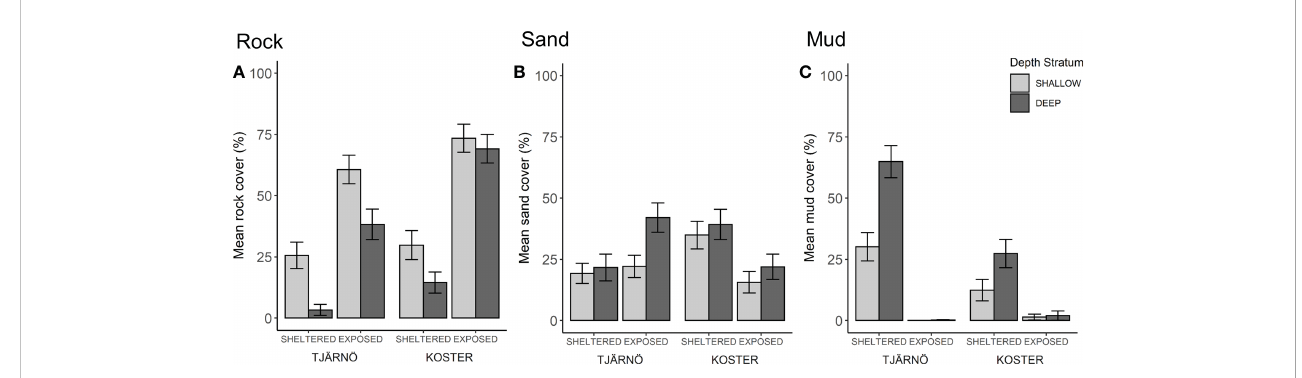
FIGURE 2 Averagecoverof rock [ (A) , including boulders and stones], sand (B) and mud (C) measured using visual inspections in 1x1 m sampling quadrats (mean ±